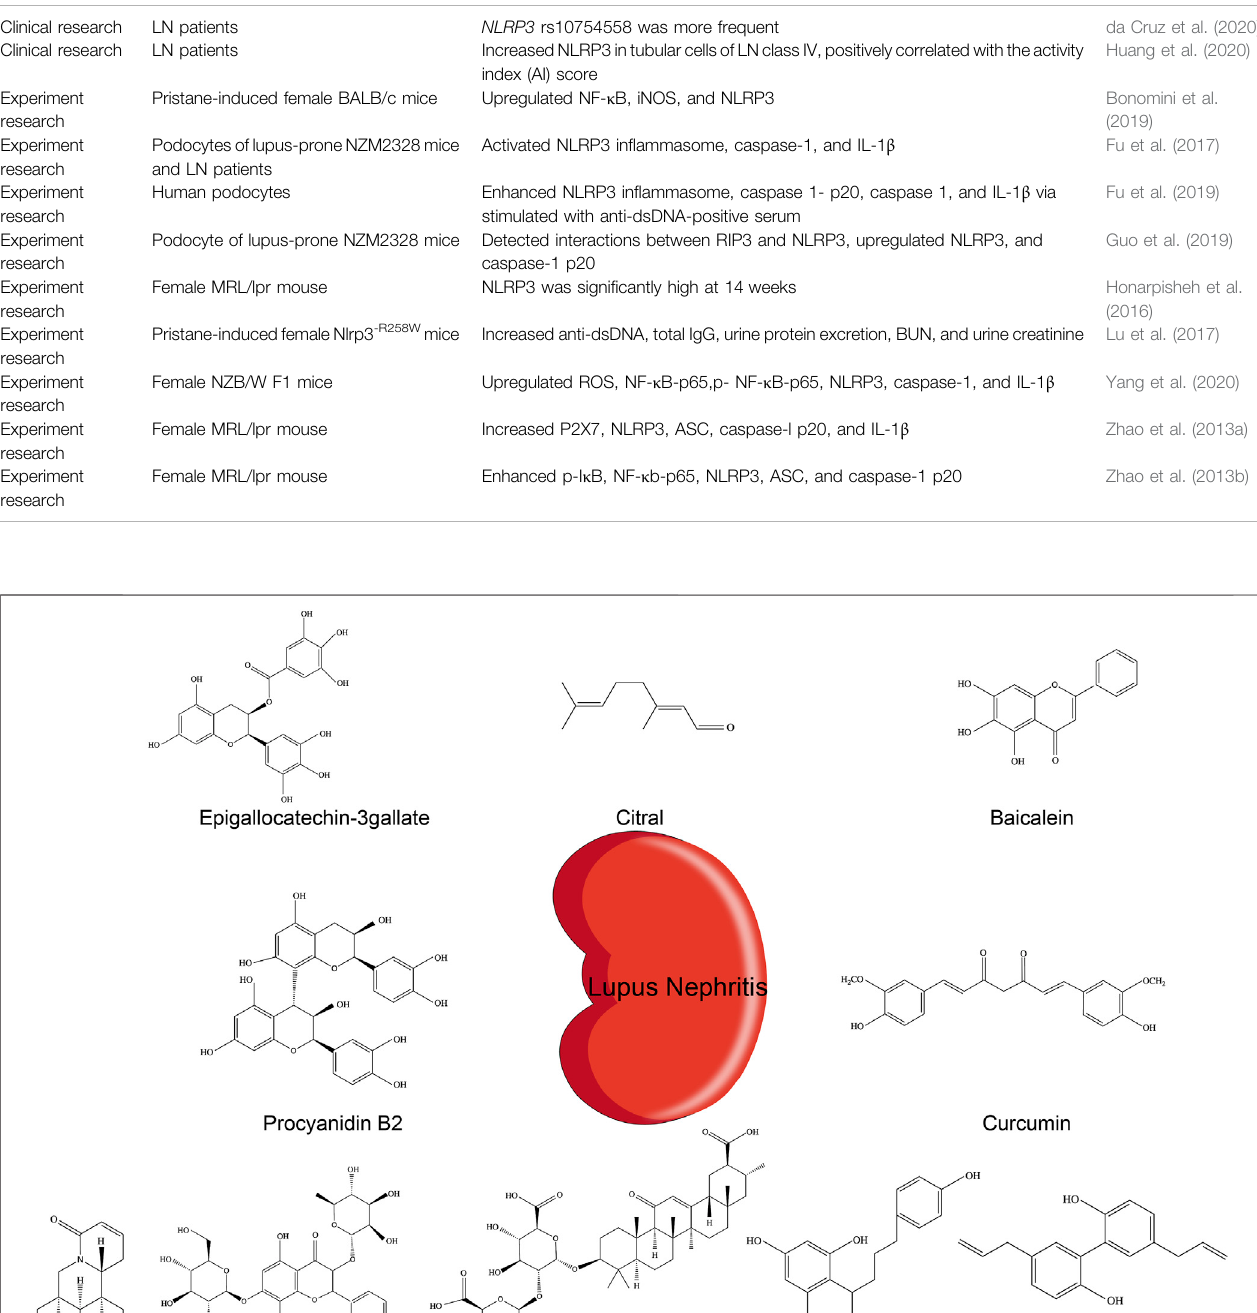
Frontiers in Pharmacology |